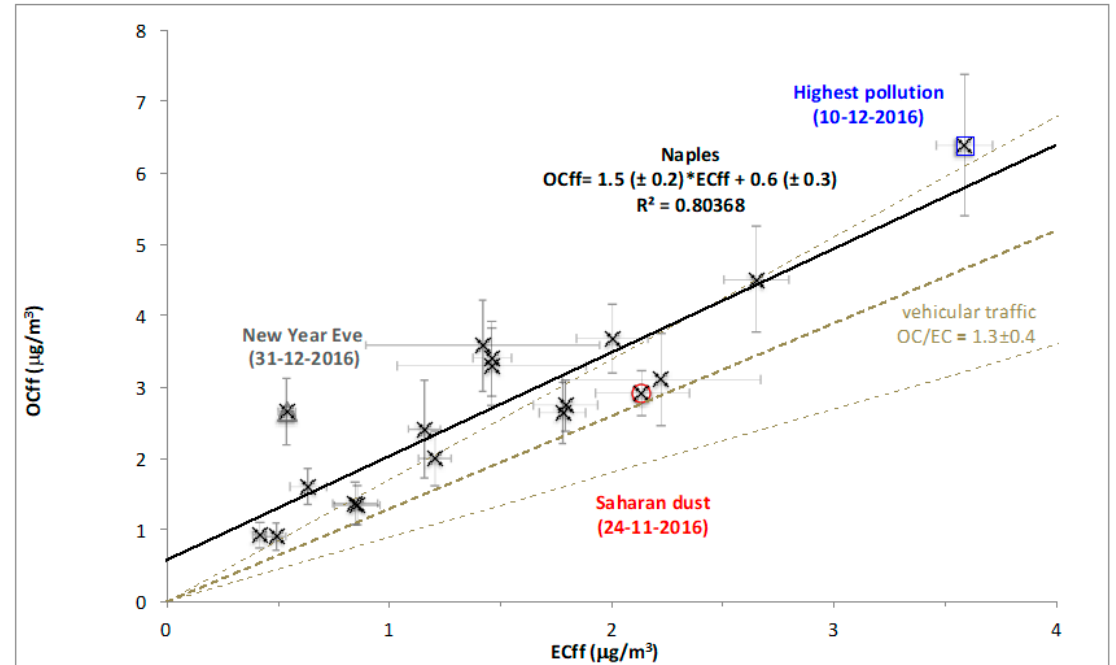
Figure 6. Correlation between OC ff and EC ff , in the city center of Naples. Solid line is the regression line through the observations. Dotted lines resemble primary vehicular tra ffi c emissions simulated by accounting emission ratio (OC / EC) ff in the range from 0.9 to 1.7, as reported in literature. Peculiar sampling days have been shown with di ff erent symbols and labelled.